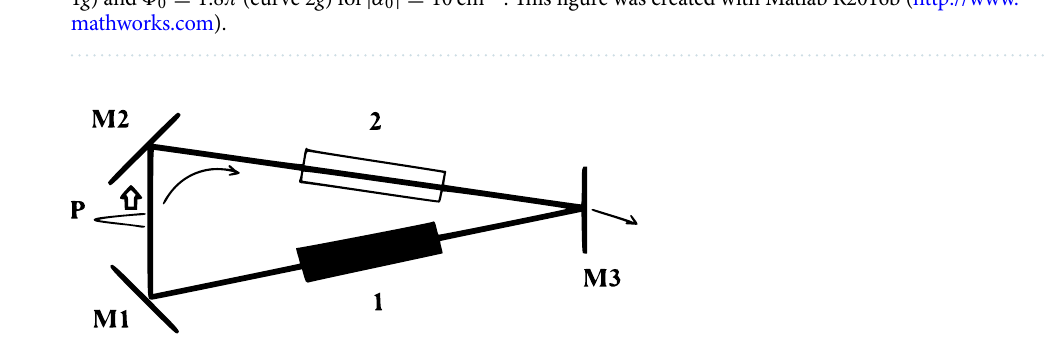
1 . This figure was created with Matlab R2016b (http://www.